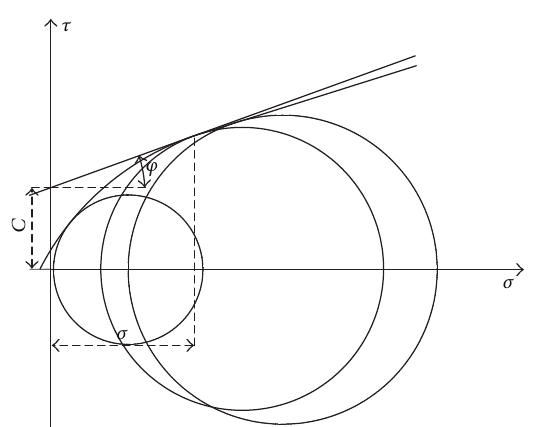
Figure 13: Mohr’s envelope in the form of quadratic parabola.